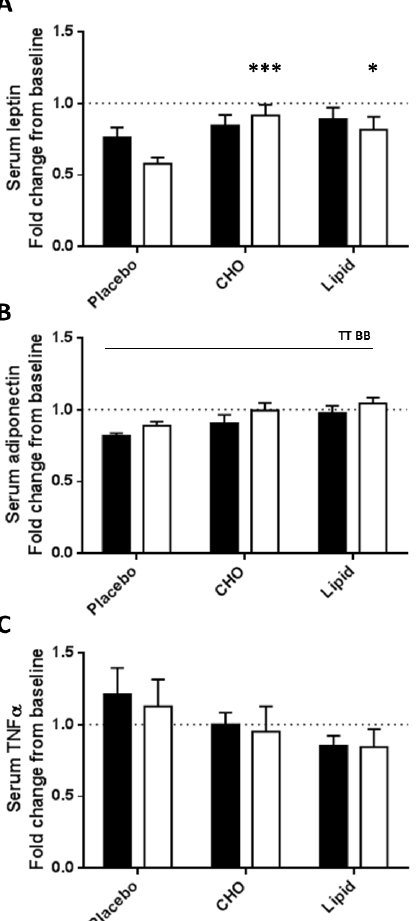
Figure 2. Serum levels of leptin ( A ); adiponectin ( B ) and TNF- α ( C ) were measured at baseline (0 h—set to 1; dotted line) and at 2 h (black bars) and 4 h (open bars) post ingestion of either a placebo, carbohydrate or lipid beverage. Serum adipokine levels were determined using a multiplex array system. Data are presented as mean fold change from baseline (set at 1) ± standard error of the mean (SEM) ( n = 11). Interaction; * p < 0.05; *** p < 0.001 versus placebo. Main effects across total sample (indicated by black line); TT = time effect p < 0.01; BB = beverage effect p <